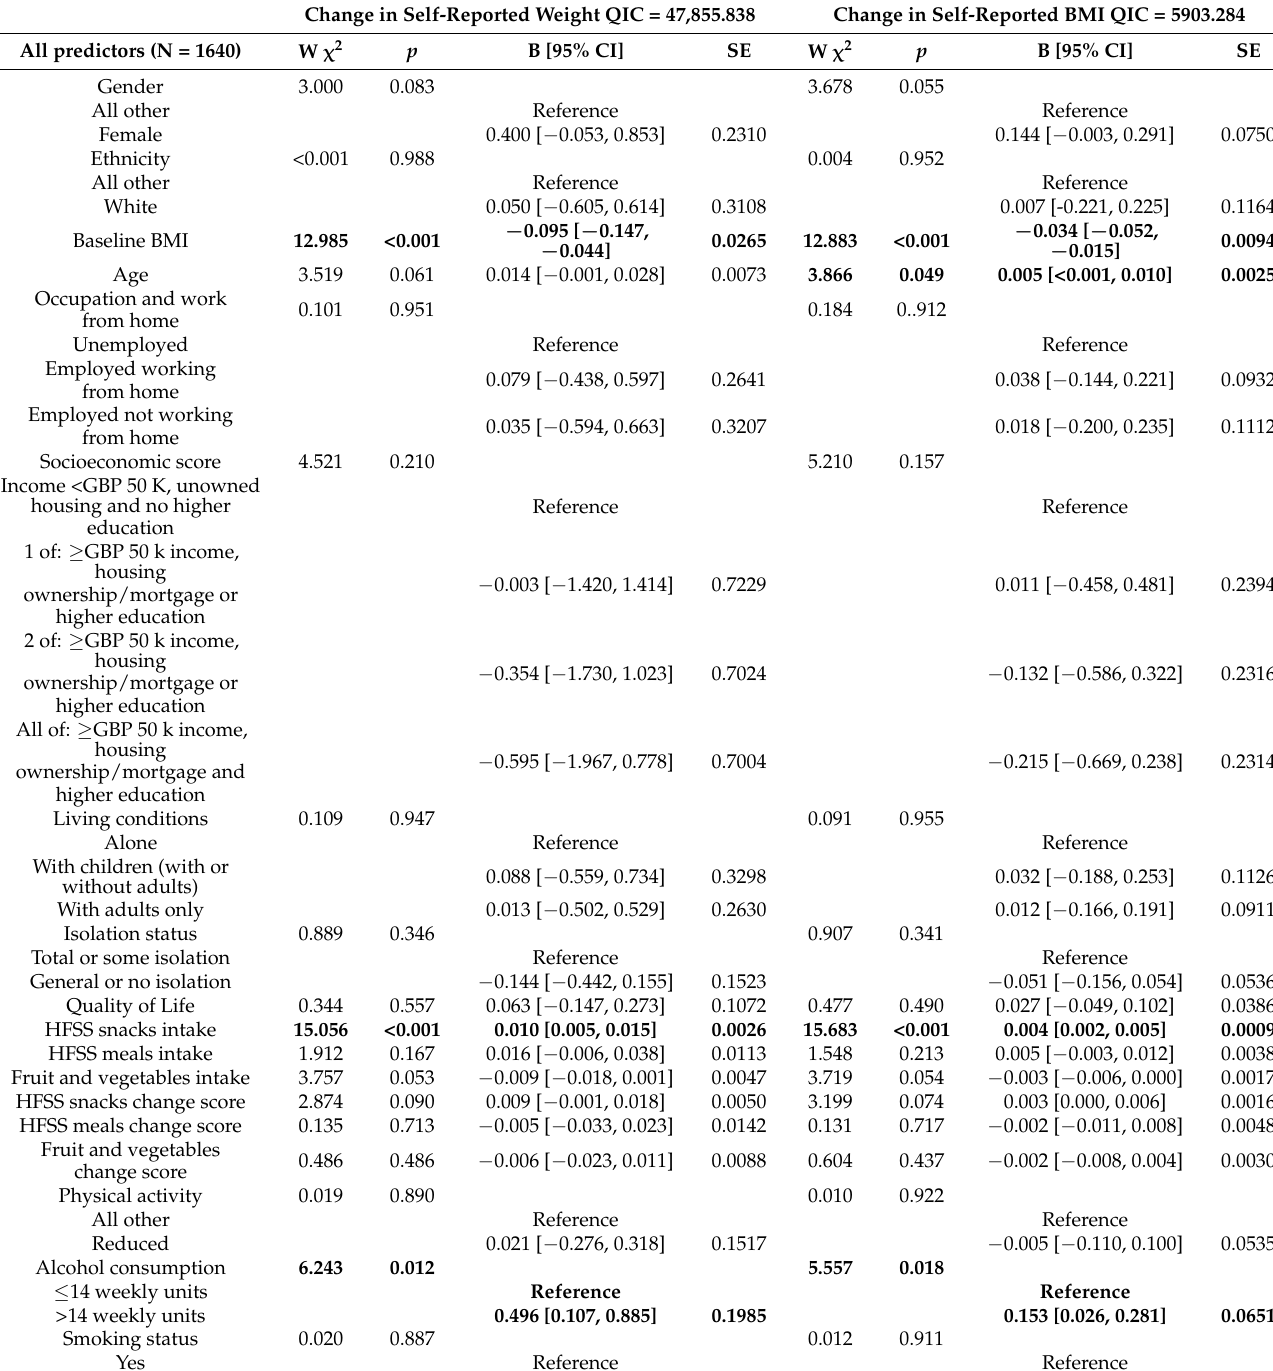
risk alcohol consumption now also significantly associated with an increase in self-reported weight/BMI and neither ∆ HFSS snacks change score nor lower fruit and vegetables intake remaining associated. However, based on significant time*explanatory variable interac- tions from the univariate GEE models (Supplementary Table S4) carried over to the fully adjusted GEE model (Table 3), baseline BMI, HFSS snacks intake and alcohol consumption all demonstrated significant interactions with time and improved model fit. Main effects were not materially altered by the addition of time interactions. Table 3. Full GEE model containing all predictor variables and the full GEE model containing all predictor variables and significant predictor*time interactions from univariate models adjusted for time. Change in Self-Reported Weight QIC = 47,855.838 Change in Self-Reported BMI QIC =